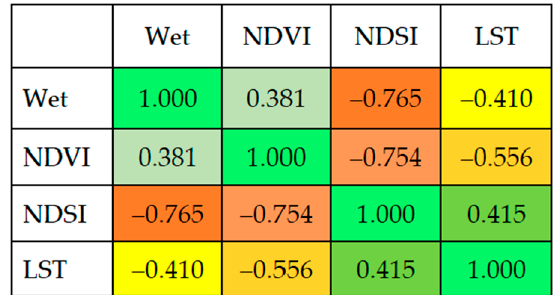
Figure 3. Correlations matrix of the four indicators.